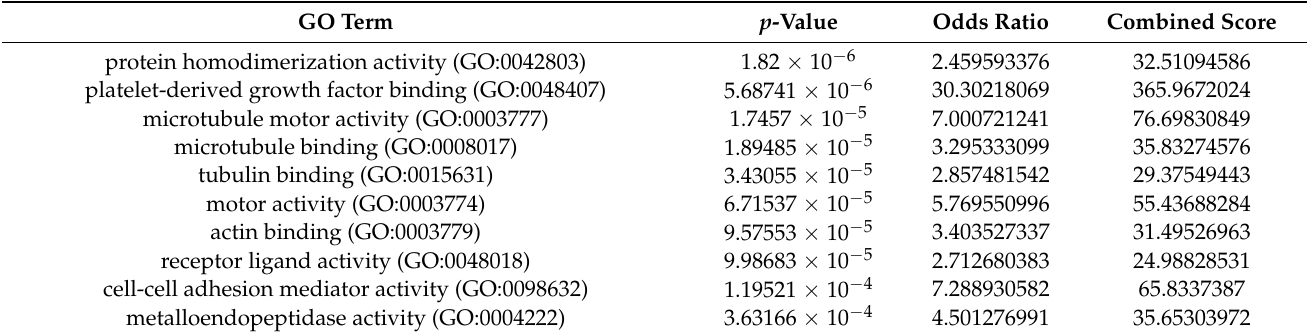
Table 3. The top 10 enriched GO terms in which the DEGs were significantly enriched, in the molecular function group.